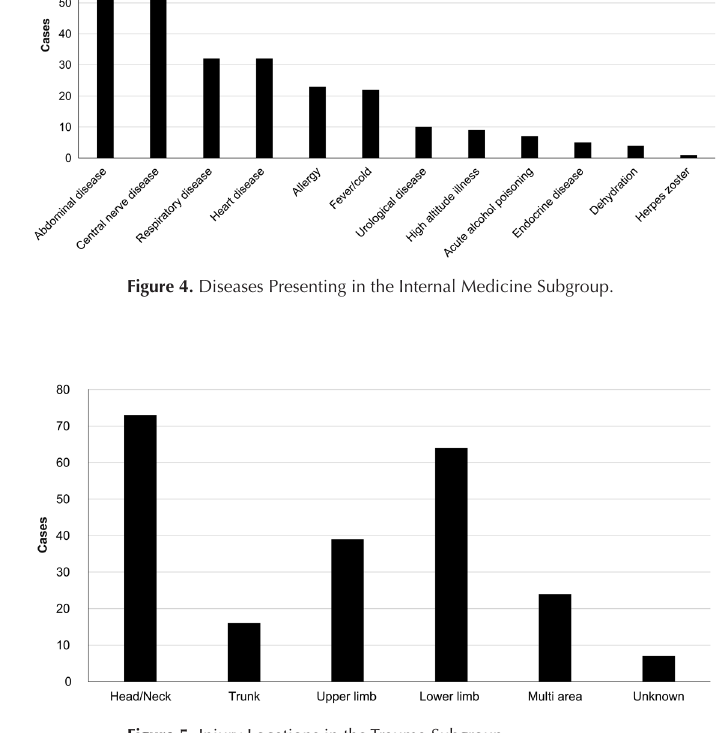
Figure 5. Injury Locations in the Trauma